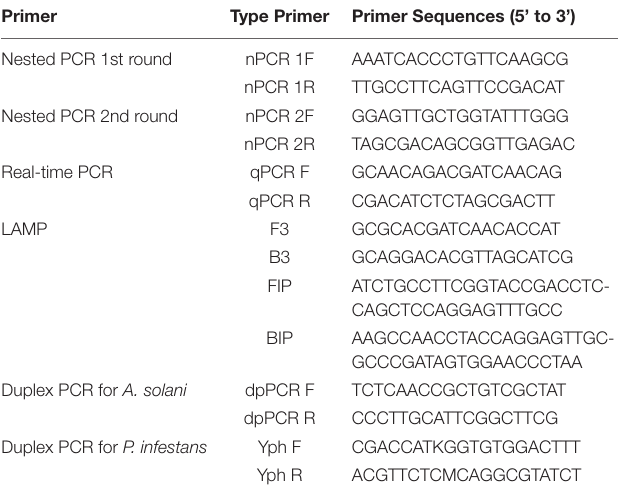
TABLE 2 | Primers used in this study.